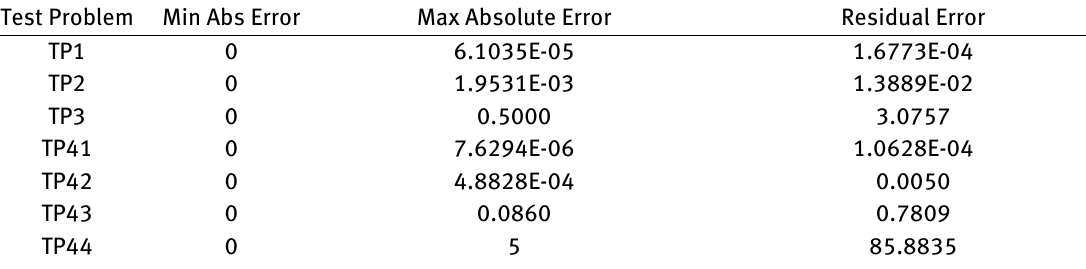
Table 2: Errors for the MFPTs (Single Precision).